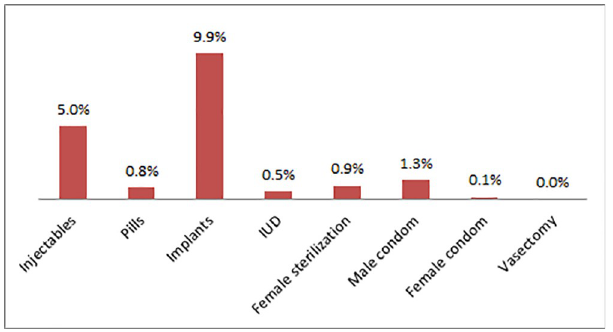
Fig 1. The most preferred contraceptive method among postpartum women (N = 61).